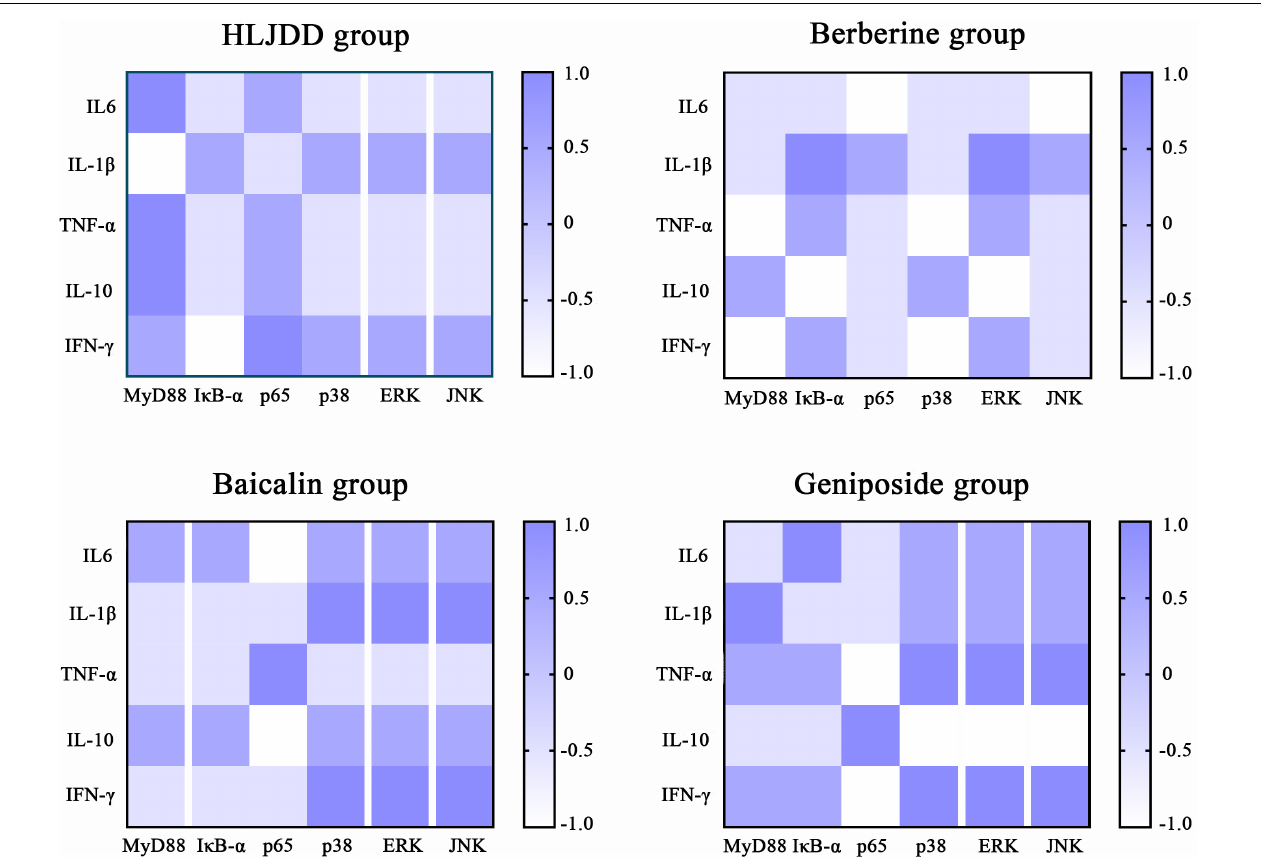
FIGURE 3 | Correlation analysis of inflammatory cytokines and mediators of the TLR4/MyD88 signaling pathway in each drug treatment group. The color scale illustrates the magnitude of correlation between the examined indexes on the